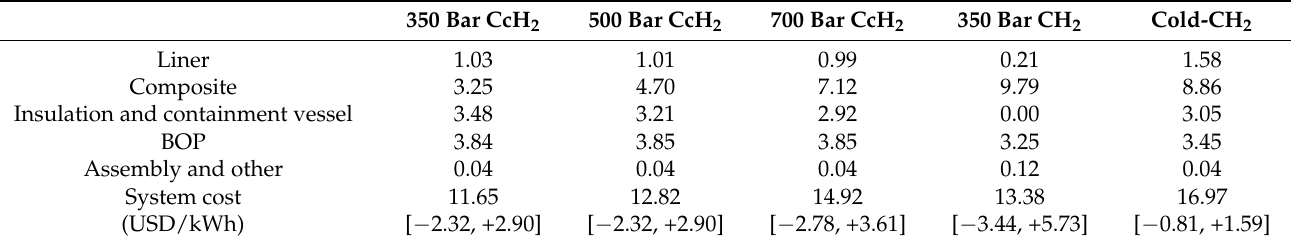
Table 5. Storage system cost comparison between CH 2 , Cold-cH 2 , and CcH 2